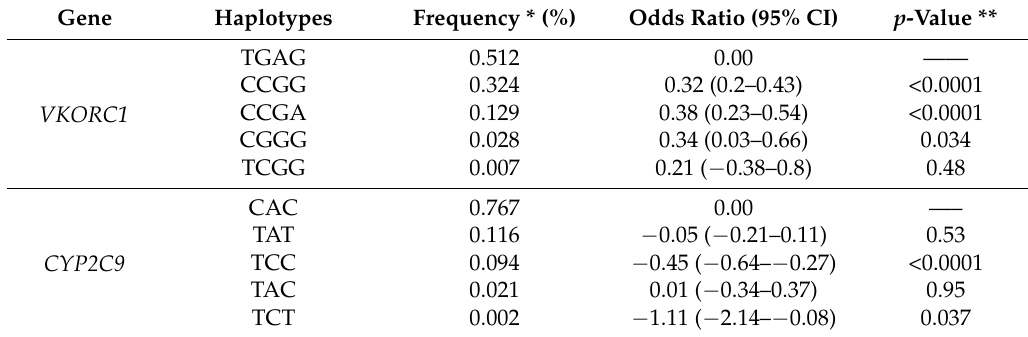
Table 3. Frequencies of the haplotypes of VKORC1 and CYP2C9 genes among the 212 warfarin sensitive patients.